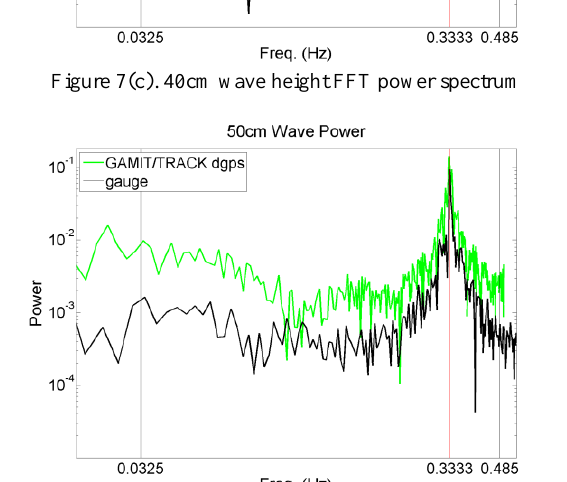
Figure 7(d). 50cm wave height FFT power spectrum Like the results of GNSS, the IMU results in Figure 8 show the similar results as GNSS only when the wave height reach 40 or 50cm, as some differences appear between two of